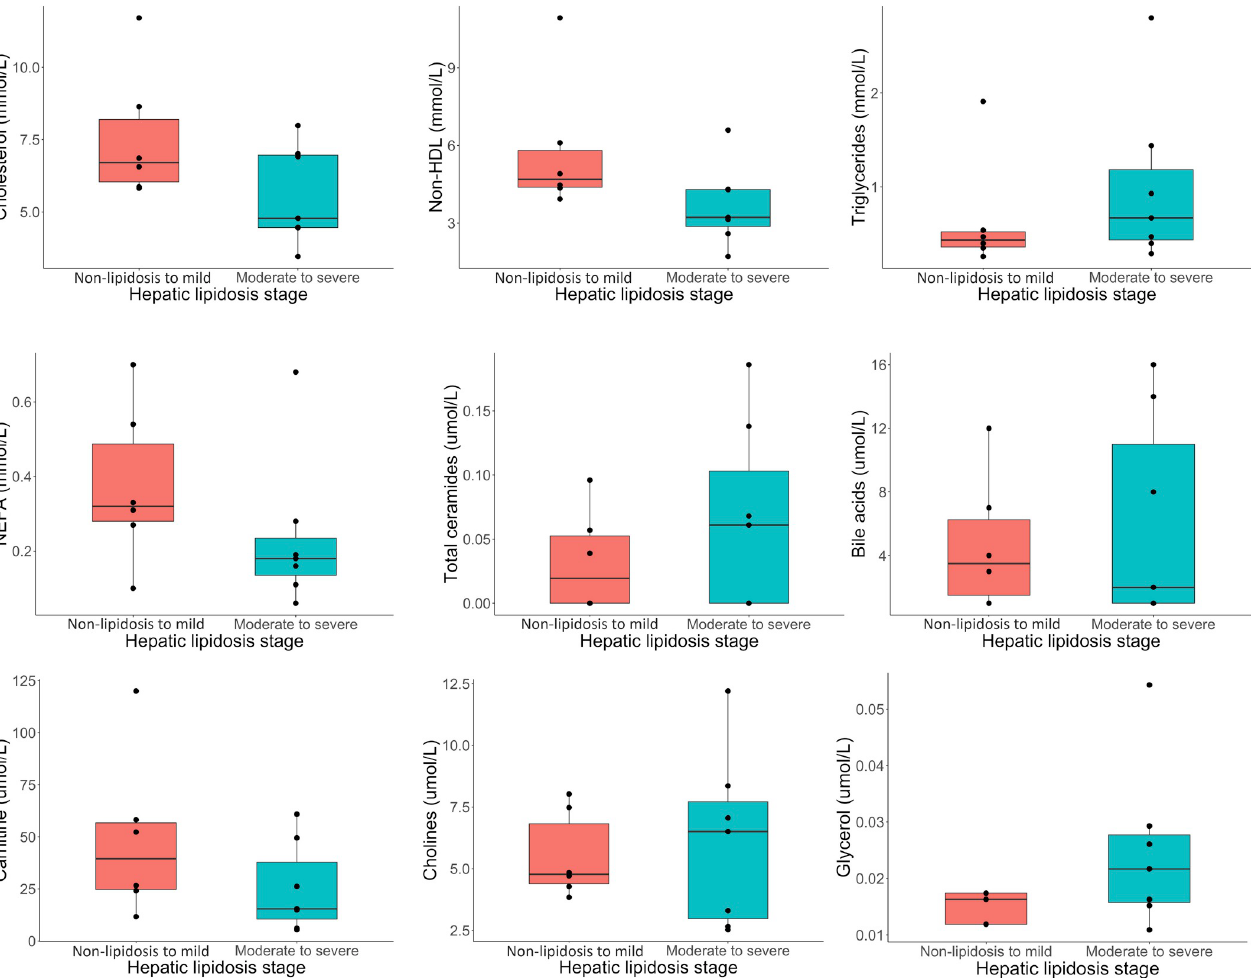
Fig 7. Heatmap showing clustering of metabolites and biochemical analytes between simplified classes of hepatic lipid changes (no-lipid to mild and moderate to severe) in bearded dragons based on an established grading system [30]. A clustering dendrogram is also present on the left; the different bearded dragons are on the x-axis and the analytes on the y-axis. Only the 75 most important analytes based on their t-test p-values are displayed. It should be noted that most of these analytes did not show significant differences between histologic classes on univariate analysis with a false discovery rate of 0.05. Color coding represents fold changes on normalized plasma concentrations with an increasing depth of orange representing increase in analyte concentration and an increasing depth of blue representing decrease in analyte concentration.